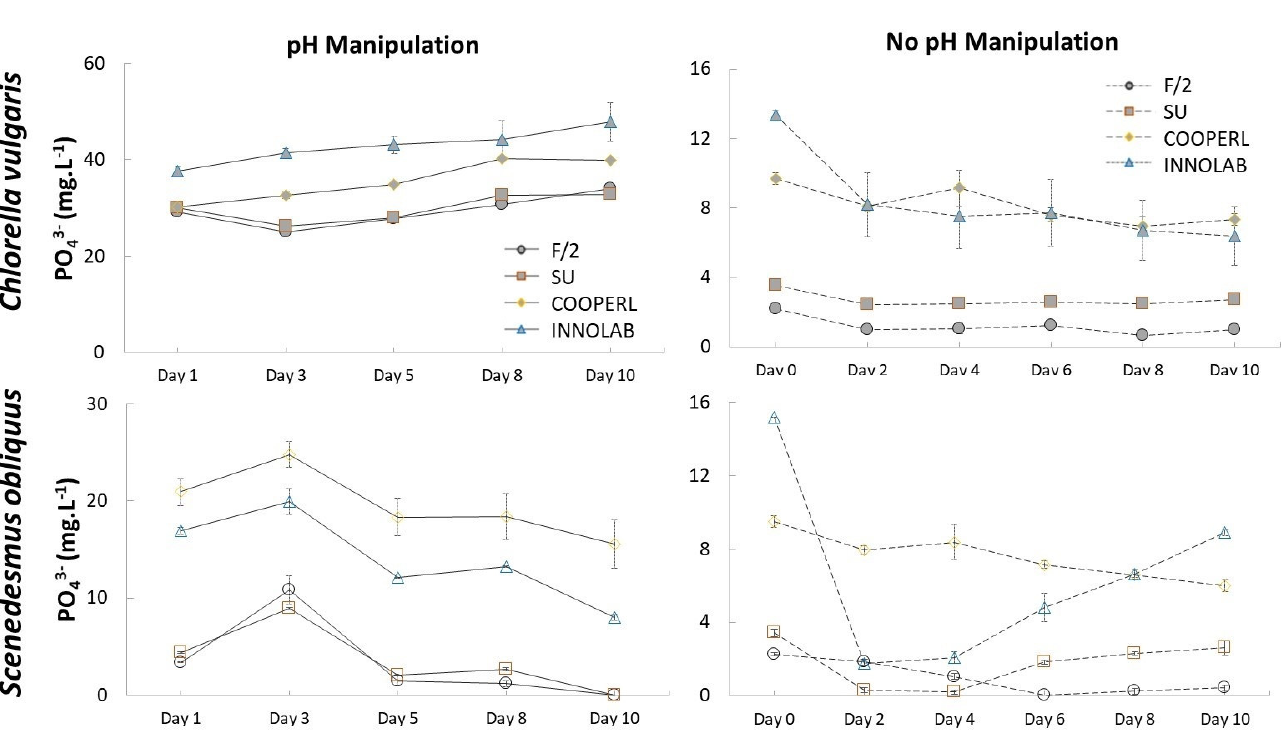
Figure 4. Concentration of phosphorus PO 43 − in cultures of C. vulgaris and S. obliquus grown on three different digestates under pH manipulation and no pH manipulation for 10 days of experiment. Error bars represent the standard deviation on three replicates.